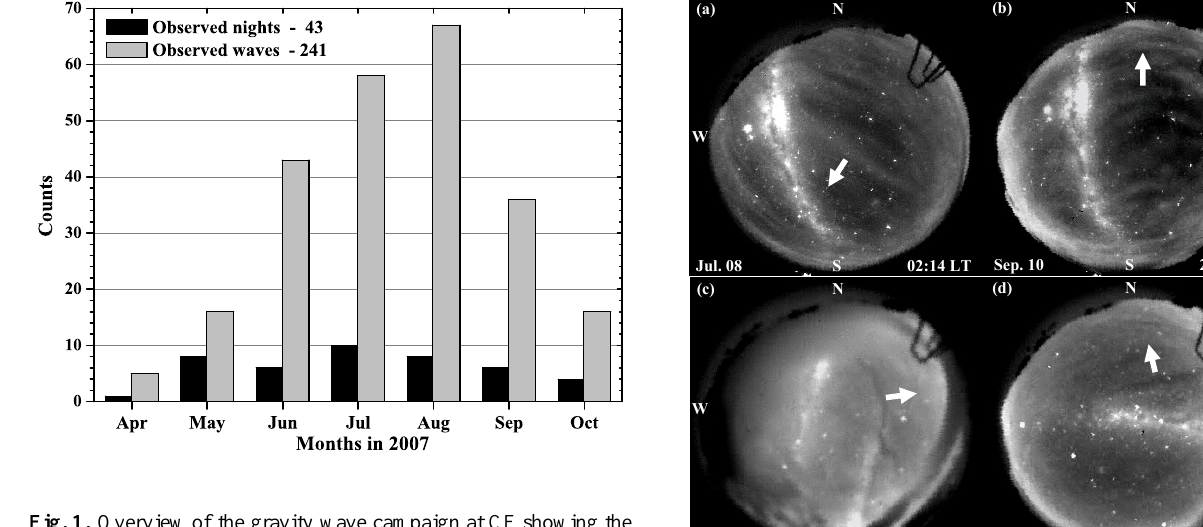
Fig. 1. Overview of the gravity wave campaign at CF showing the number of nights with observed waves (black) and also the total amount of waves in each month (gray).